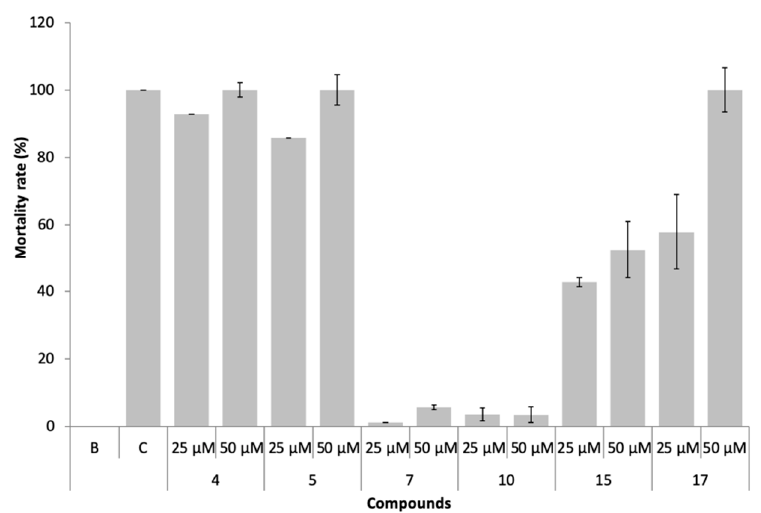
Figure 8. Mortality rate of Artemia salina exposed to the compounds 4 , 5 , 7 , 10 , 15 , and 17 at 25 and 50 μ M.